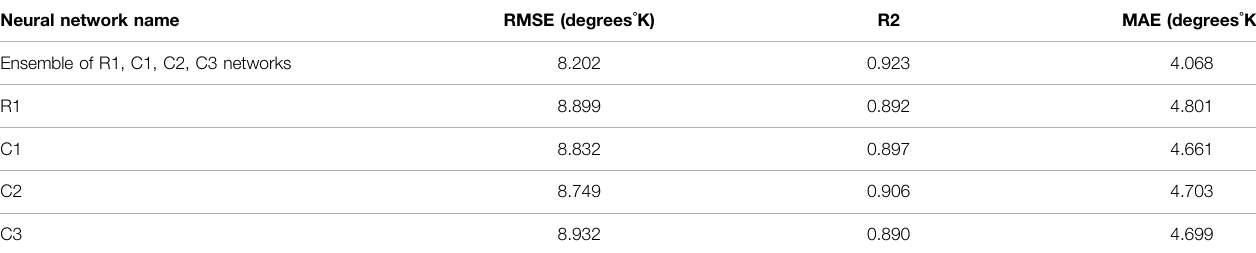
TABLE 4 | Accuracy metrics of ensemble.